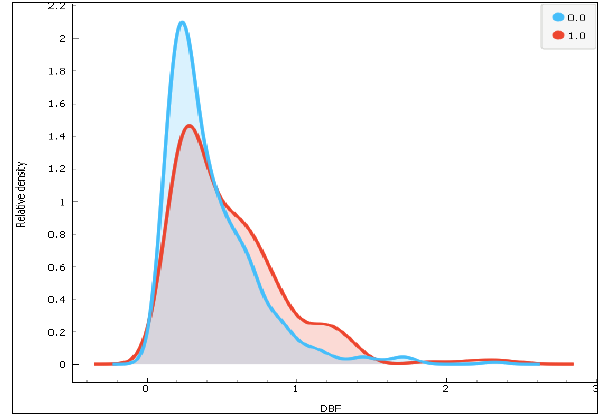
Figure 9. The distribution of the diabetes pedigree function(DBF) for the two classes.